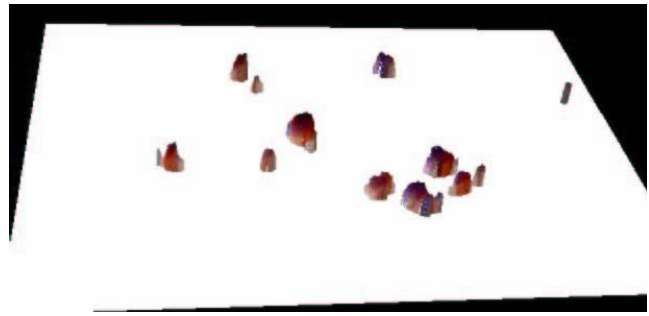
Fig. 5 Spatial visualisation of Ki67 protein presented in Figure 4.